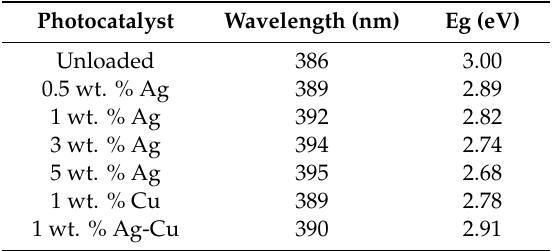
Figure 5. UV–vis di ff use reflectance spectra of Ag-loaded TiO 2 (40%) / ZeY (100%). The inset shows plots of (F(R) · h ν ) 0.5 versus h ν of the catalysts. Figure 5. UV–vis diffuse reflectance spectra of Ag-loaded TiO 2 (40%)/ZeY (100%). The inset shows plots of (F(R) ⋅ h ν ) 0.5 versus h ν of the catalysts. Table 3. Summary of characteristics of Ag-loaded TiO 2 (40%) / ZeY (70%) catalysts prepared Table 3. Summary of characteristics of Ag-loaded TiO 2 (40%)/ZeY (70%) catalysts prepared by